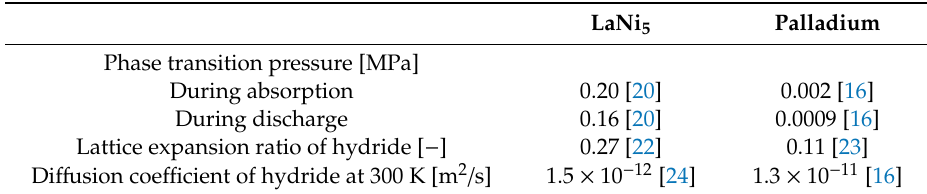
Table 1. Material parameters of LaNi 5 and